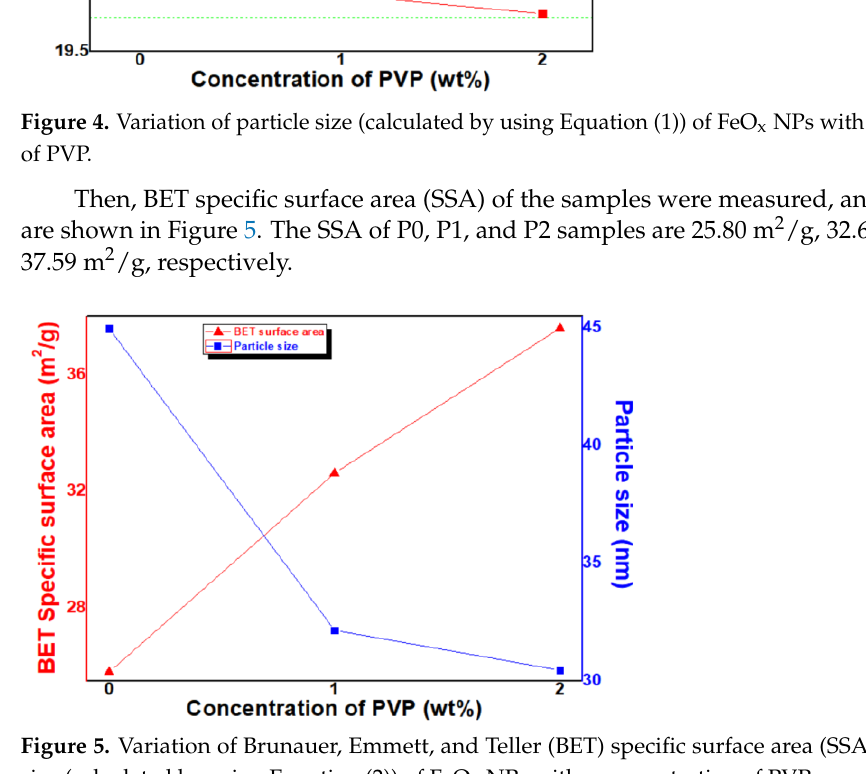
Figure 4. Variation of particle size (calculated by using Equation (1)) of FeO x NPs with concentration of PVP.